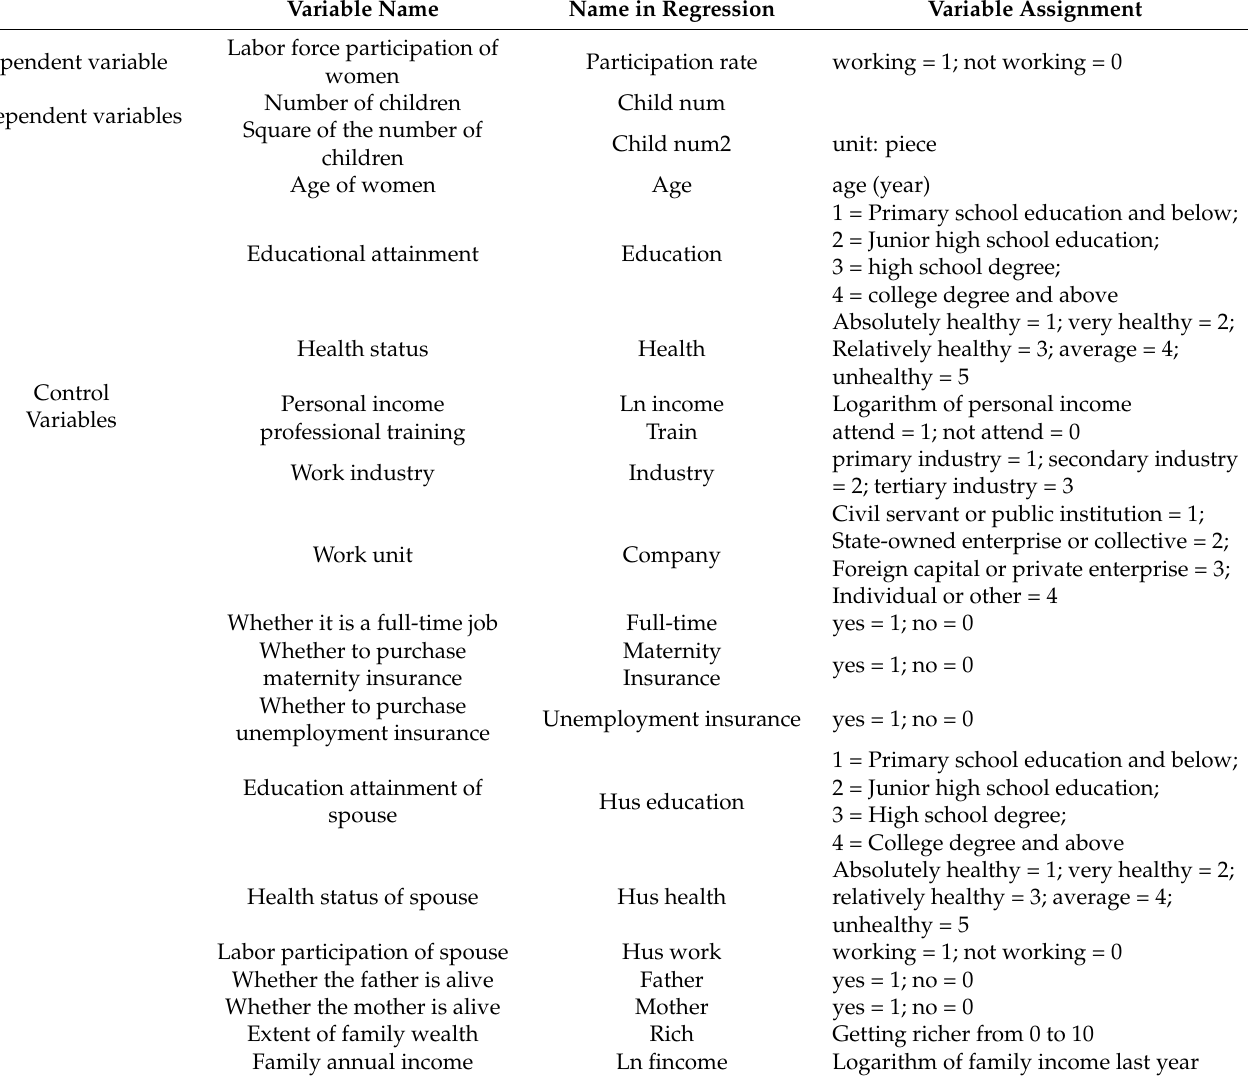
Table 1. Variable Description and